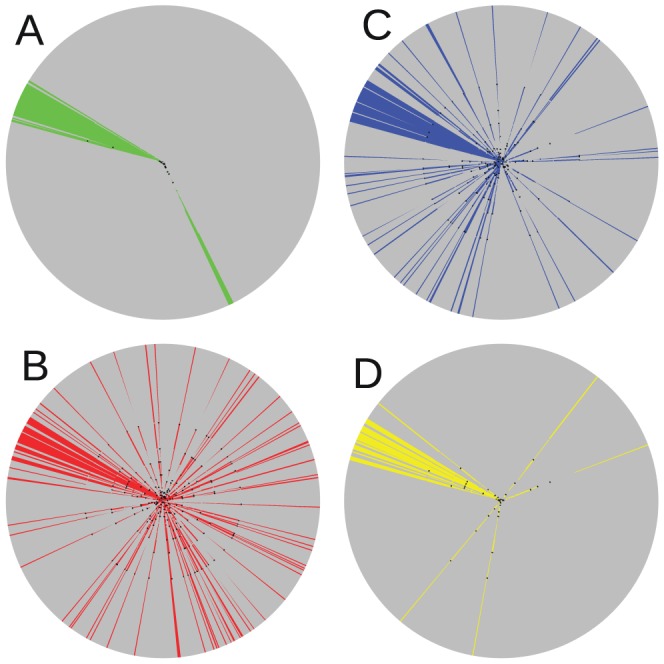
Phylogenetic fan tree of subtype B/B' Env sequences.The four panels show four times the same tree with coloring highlighting different properties. A: sequences from China in green; B: sequences with L14 in red; C: sequences with W22 in blue; D: sequences carrying signature pattern 1 (L14 and W22) in yellow.